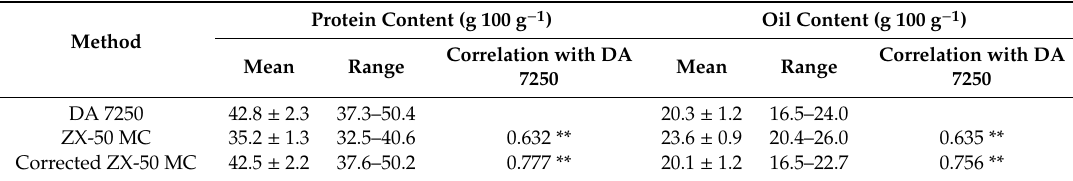
Table 7. Application of the ZX-50 MC NIR method to single-plant evaluation of seed protein and oil content in 240 whole seed samples of